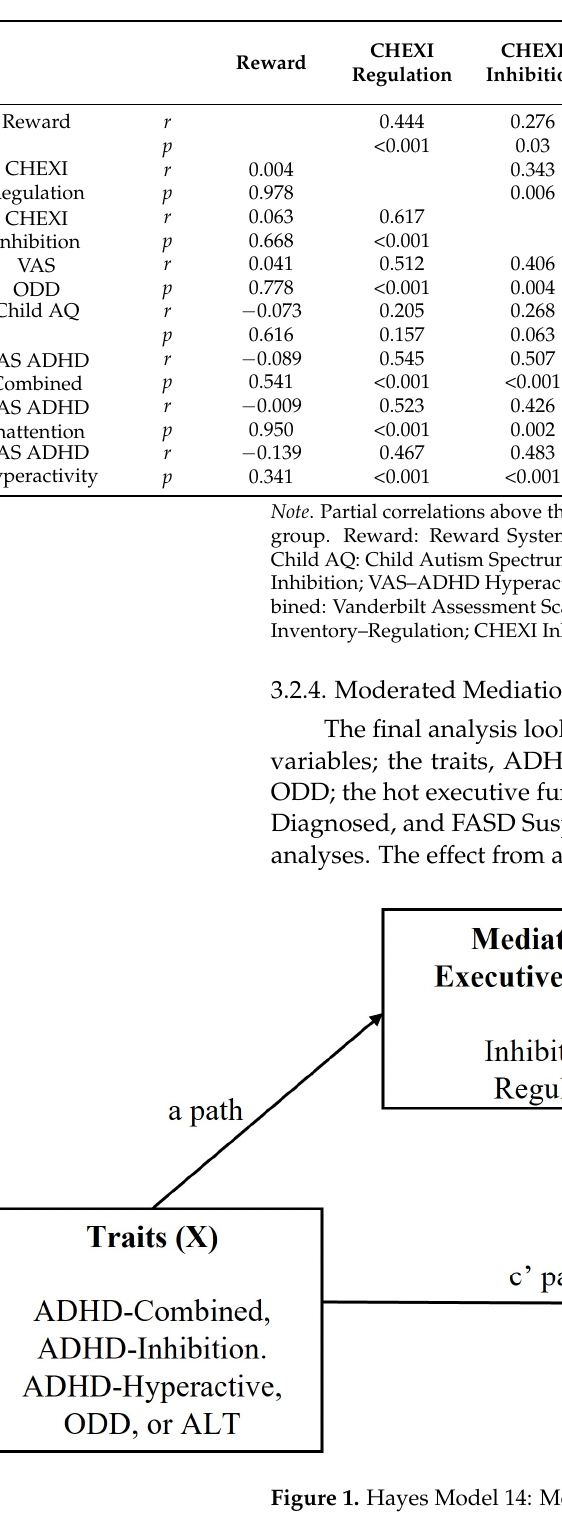
Table 3. The model coefficients and model summary information for the conditional process (Model 14) in the relationship between ADHD-Combined and the helpfulnes of rewards, where FASD diagnostic status moderated the mediation effect of Regulation. Consequent M (Regulation)